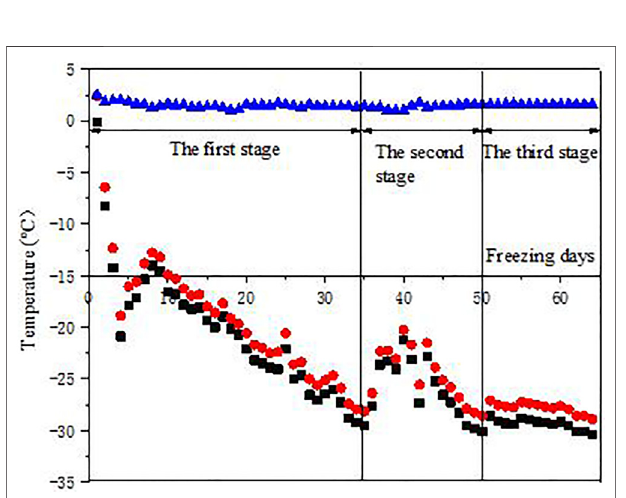
FIGURE 6 | Site layout of the west end of Zhuyuan Road Station.